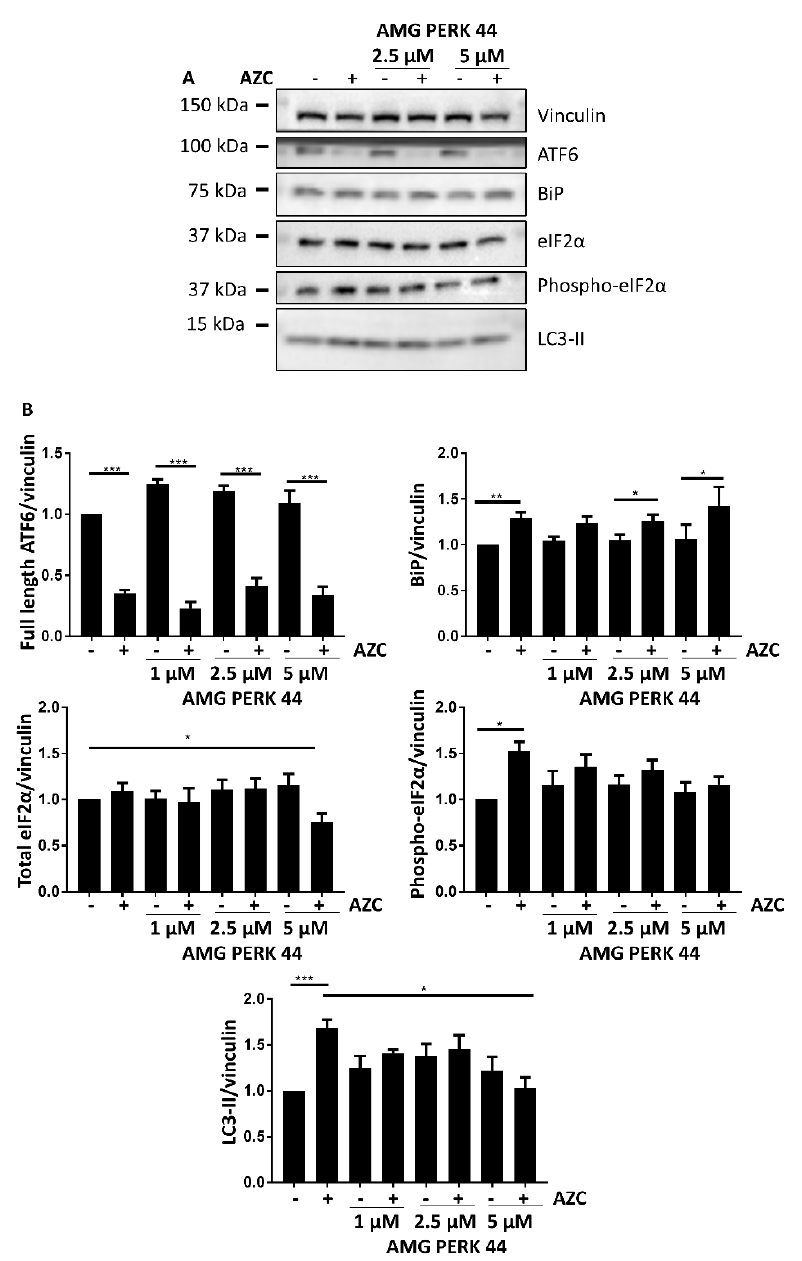
Figure 4. AZC elevates LC3-II levels in a PERK-dependent manner. Cells were treated for 6 h with 5 mM AZC in absence or presence of 1 µ M, 2.5 µ M, or 5 µ M of the PERK inhibitor AMG PERK 44, and during the last 4 h 100 nM Baf A1 was added. ( A ) A representative blot for six independent experiments each performed in duplicate in absence or presence of AMG PERK 44 (2.5 and 5 µ M) showing protein levels of ER stress markers ATF6, BiP, total eIF2 α , and phospho-eIF2 α and of autophagy marker LC3-II. Vinculin was used as loading control. ( B ) Quantification of ER stress and autophagy markers in ( A ) as well as of independent experiments performed in absence or presence of AMG PERK 44 (1–5 µ M), shown as mean ± SEM relative to untreated control. * p < 0.05, ** p < 0.01, *** p < 0.001.